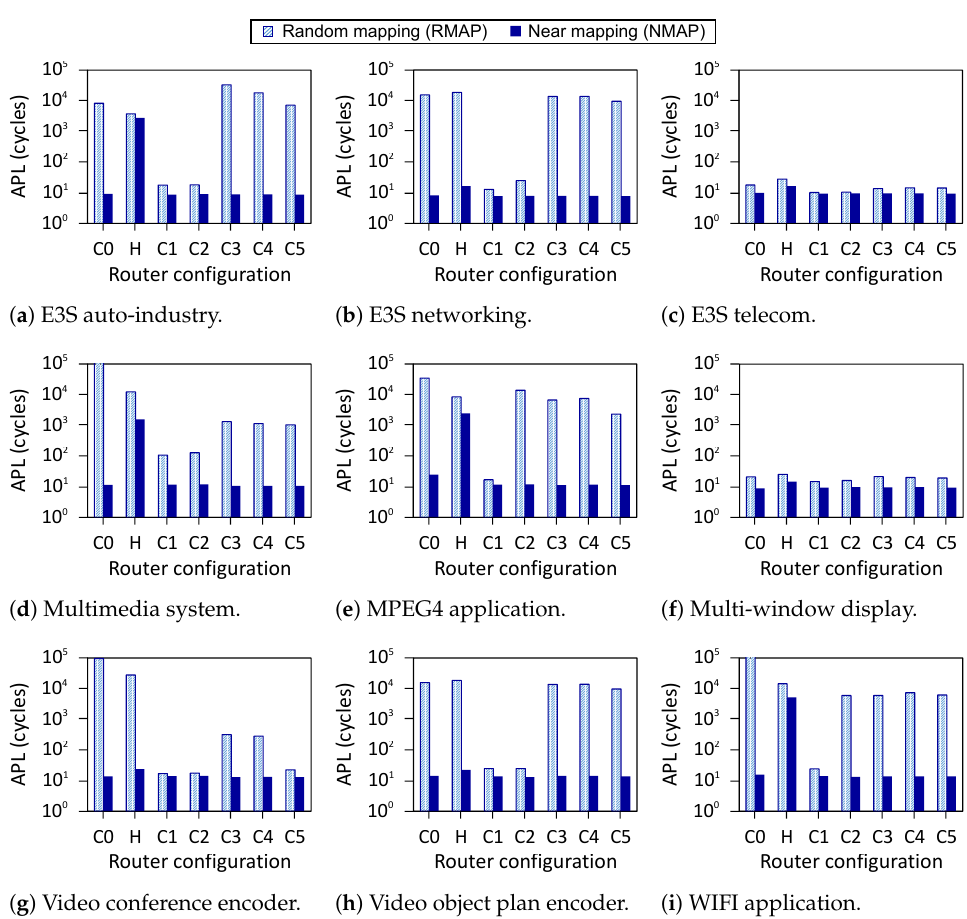
Figure 19. Performance for application. APL: Average packet latency. Y-axis uses log scale ( a – i